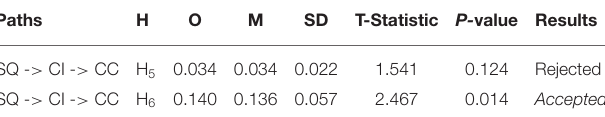
TABLE 6 | Indirect effects.